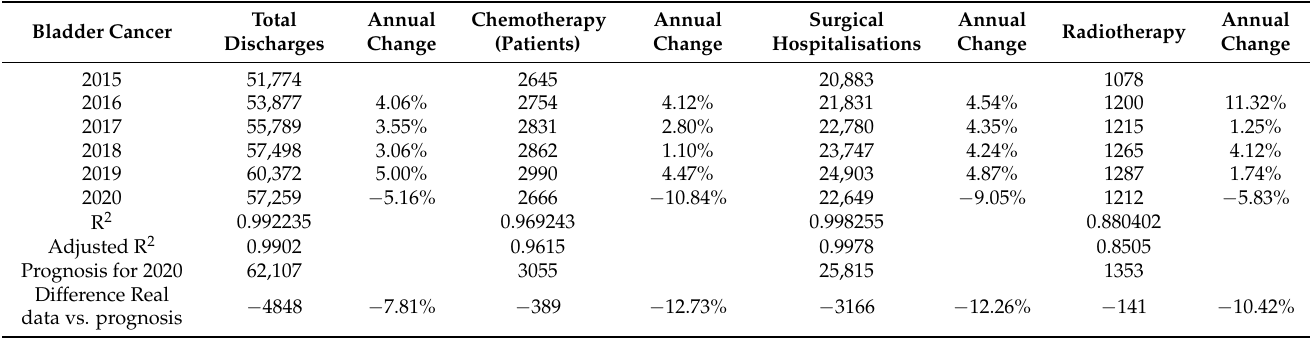
Table 7. Bladder cancer